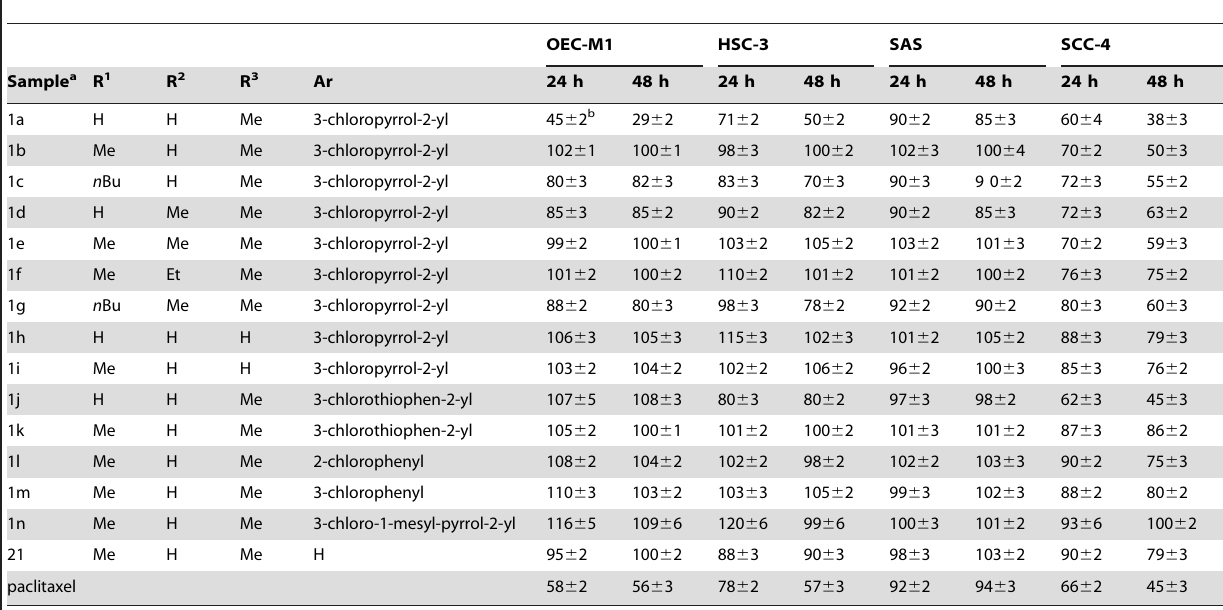
Table 1. Anticancer Activity of Gymnoconjugatin Derivatives against Human Oral Cancer